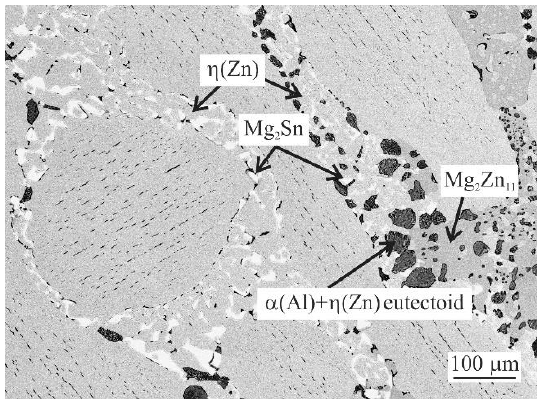
Figure 4. Binary and quaternary eutectic areas in MZ + 2.0Sn alloy microstructure after DSC meas- Figure 4. BinaryandquaternaryeutecticareasinMZ+2.0SnalloymicrostructureafterDSC